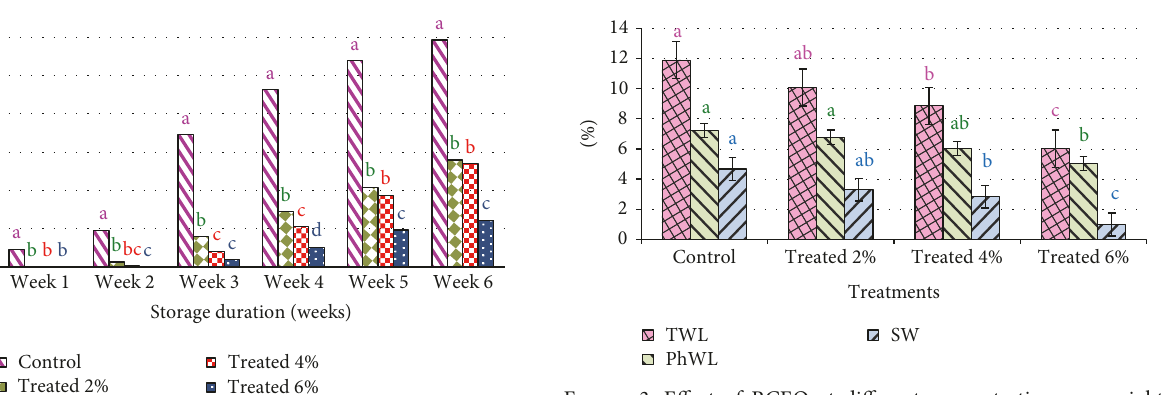
Figure 3: Effect of RCEO at different concentrations on weight loss of potato after 6 weeks of storage. TWL: total weight loss; PhWL: physiological weight loss; and SW: sprouts weight. (a, b, c) Data having different letters are significantly different ( 𝑝 ≤ 0.001 ) according to Duncan test